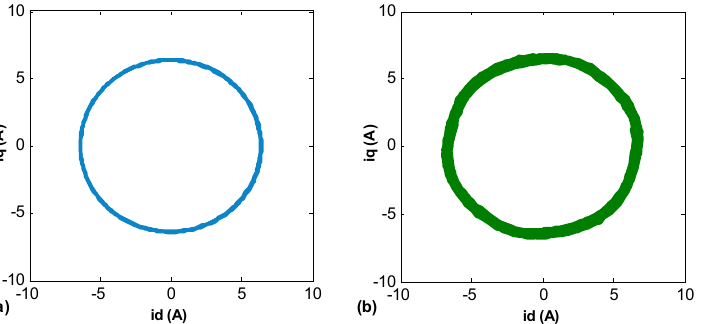
Figure 3. Park’s vector trajectories: ( a ) healthy motor and ( b ) motor with simulated BRB. Figure 4. Park’s vector trajectories: ( a ) healthy motor and ( b ) motor with one BRB (experimental result).